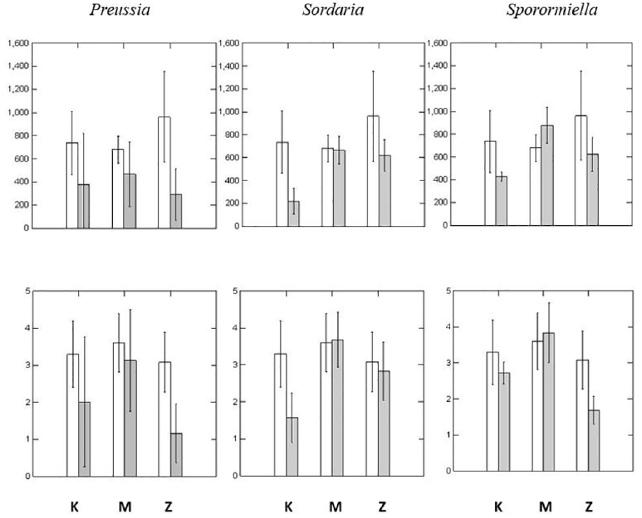
Fig 1. Fecundity (top row — seeds per plant) and growth (bottom row — grams of dry, aboveground, vegetative biomass per plant) of some populations of Bromus tectorum were significantly reduced by inoculation with representative isolates of three genera of dung fungi (i.e., Preussia , Sordaria , and Sporormiella ). Clear bars: uninoculated controls. Shaded bars: inoculated. K, M, and Z were populations of B . tectorum from seed collected in Kendrick, Idaho, McCroskey, Idaho and Zia, New Mexico, respectively. Fecundity and growth of Zia plants were negatively affected by Preussia CID 34 (P = 0.001 and P = 0.009, respectively) and Sporormiella CID 329 (P = 0.006 and P = 0.029, respectively); fecundity and growth of Kendrick plants were negatively affected by Sordaria fimicola CID 33 (P = 0.001 and P = 0.001,